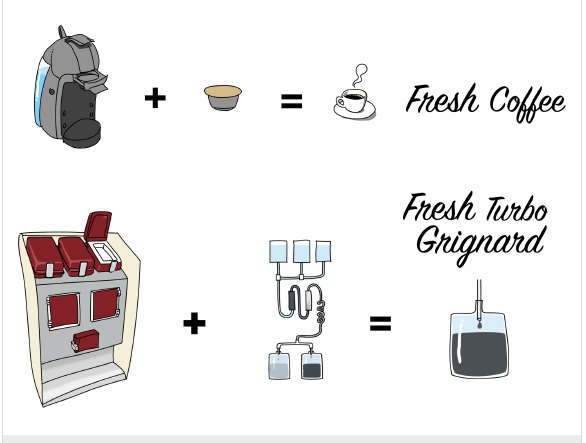
Figure 1: Comparing on-demand coffee and turbo Grignard pod-style machines.